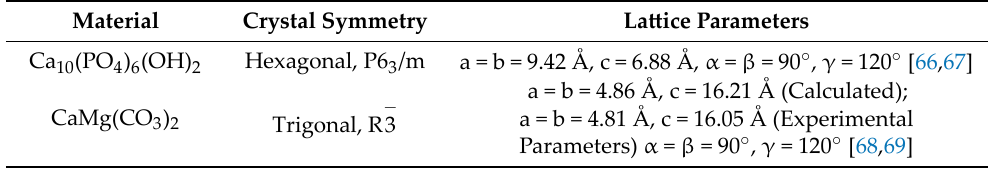
Table 2. Crystal Structures of HAP and dolomite.